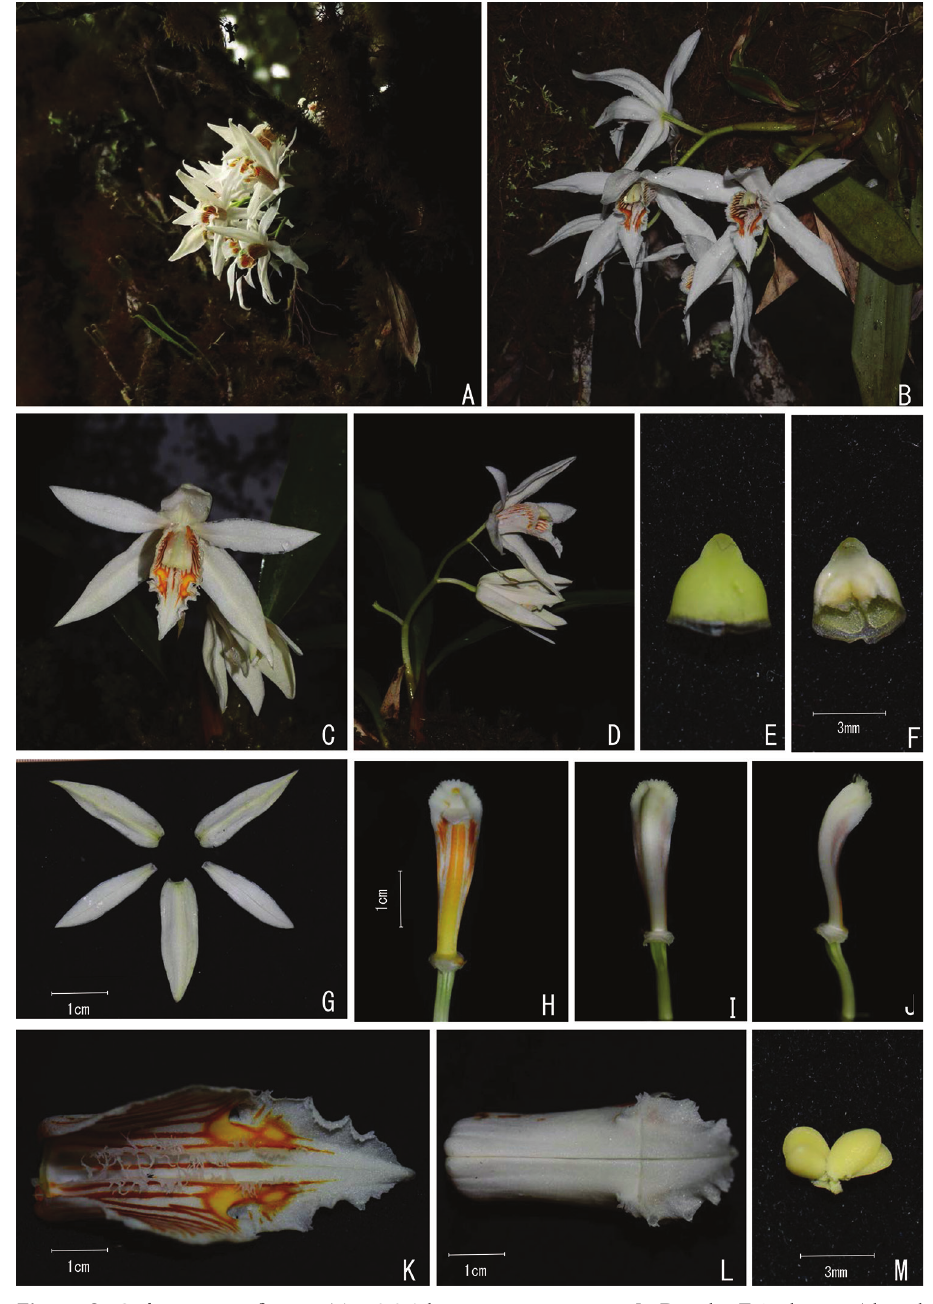
Figure 2. Coelogyne magnifica Y.H. Tan, S.S. Zhou & B. Yang sp. nov. A–D Habit E Anther cap (abaxial view) F Anther cap (adaxial view) G Tepals H Column (adaxial view) I Column (abaxial view) J Column (lateral view) K Lip (adaxial view, showing the two lateral keels and two patches) L Lip (abaxial view) M Pollinia. Photographed by Y.H. Tan, Q. Liu & X.L.